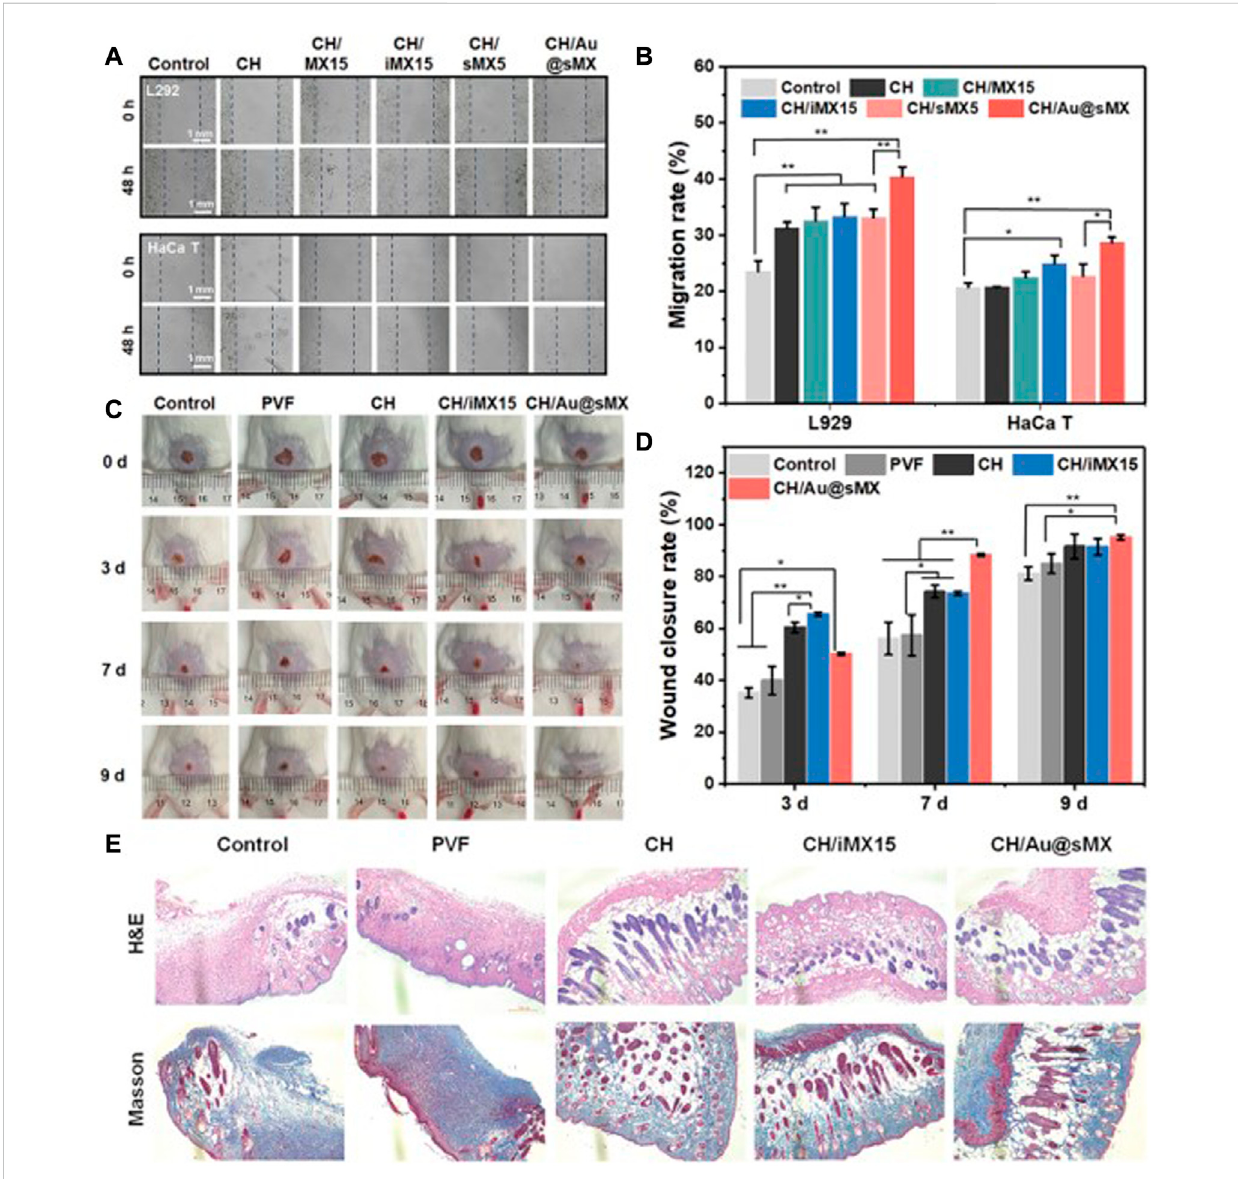
Biocompatibility of MXene-modi fi ed sponges in vivo and vitro (A) Representative images and (B) migration scratch assay of L292 and HaCaT at 48 and 0 h after scratching and treatment with 0.5 mg/ml of each sample. In vivo assessment of the sponges for wound healing (C) Photographic snapshots of temporal development of healing wounds for the different sponges in 0, 3, 7, and 9 days, respectively. (D) Wound closure rate of different sponges at different healing times (E) H&E staining and Masson staining images of the wound section at the 13th day for each group, respectively (Li et al.,